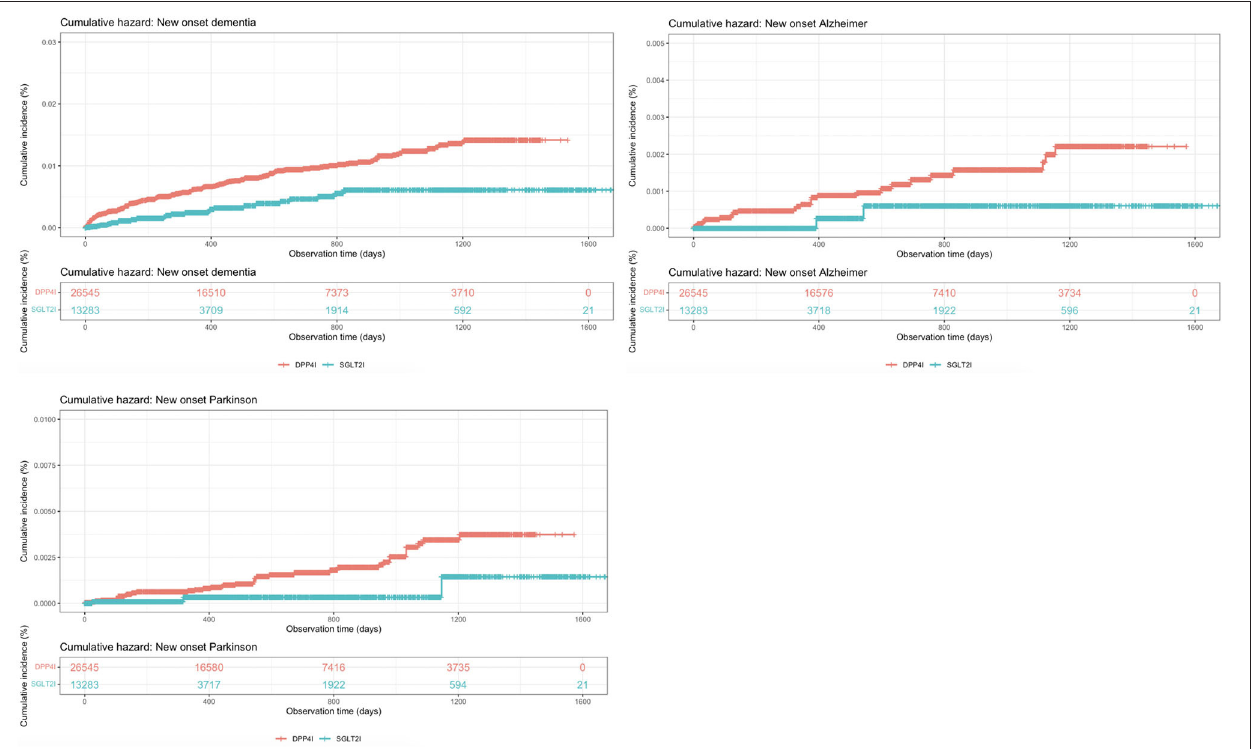
FIGURE 2 | Cumulative incidence curves for new-onset cognitive dysfunctions stratified by the drug use of SGLT2I and DPP4I after propensity score matching (1:2).